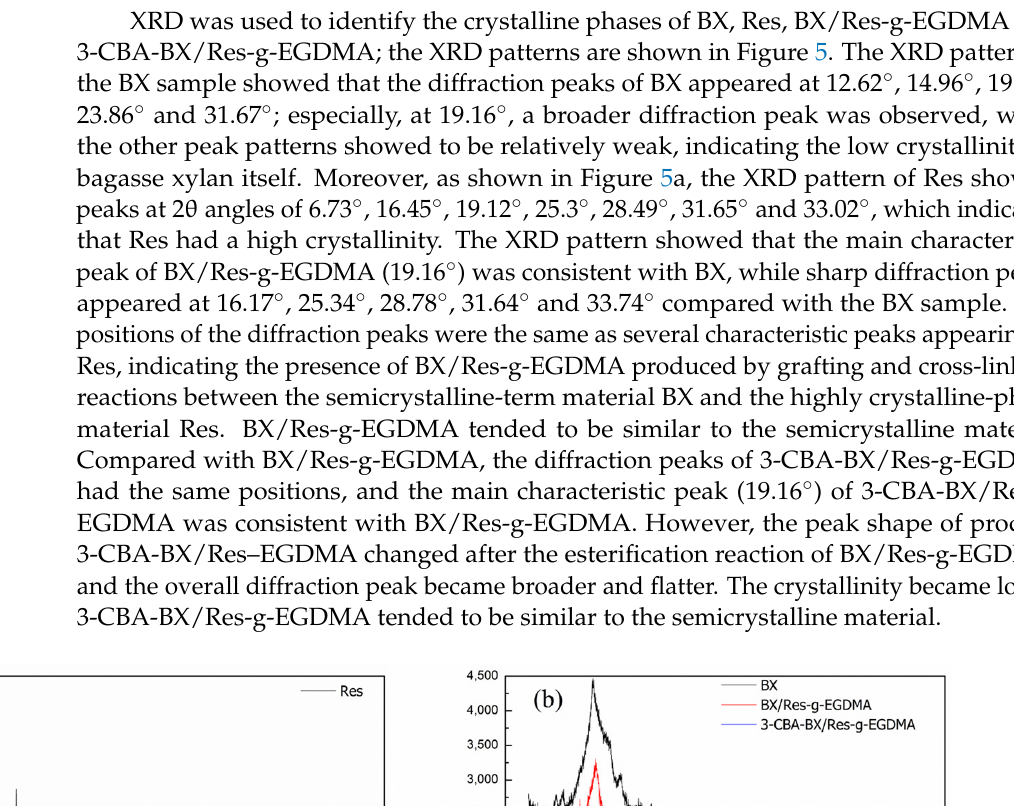
Figure 4. Spectra of BX, Res, BX/Res-g-EGDMA and 3-CBA-BX/Res-g-EGDMA. ( a ) FTIR spectra of BX and Res. ( b ) TIR spectra of BX/Res-g-EGDMA and 3-CBA-BX/Res-g-EGDMA.